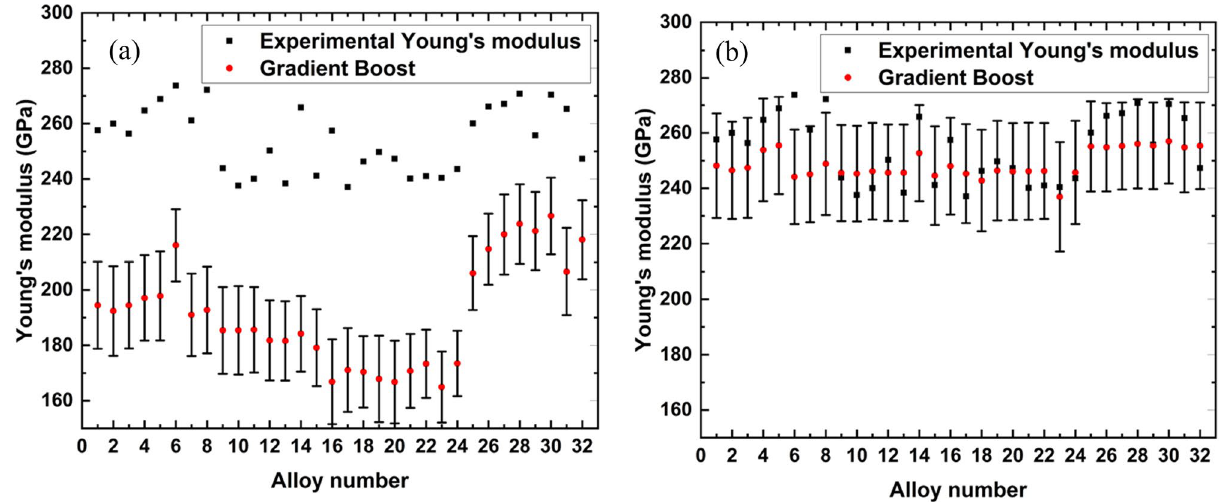
Figure 4. Young’s Modulus Prediction by Gradient Boosting model when trained (a) with data containing both refractory and non-refractory alloys and (b) with only refractory